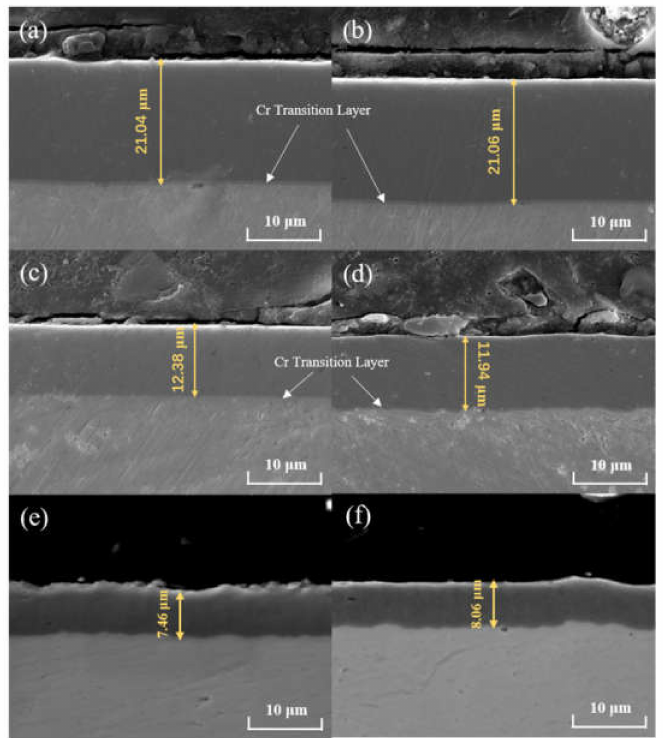
Figure 5. Cross-sectional morphologies of both sides of ( a , b ) CrN, ( c , d ) Cr 2 N, and ( e , f ) Cr coatings. The elemental distribution of the Cr-N x coatings is shown in Figure 6. According to the line scanning results, the Cr and N elements in the CrN and Cr 2 N coatings, as well as the Cr element in the Cr coating, were uniformly distributed, and the distribution